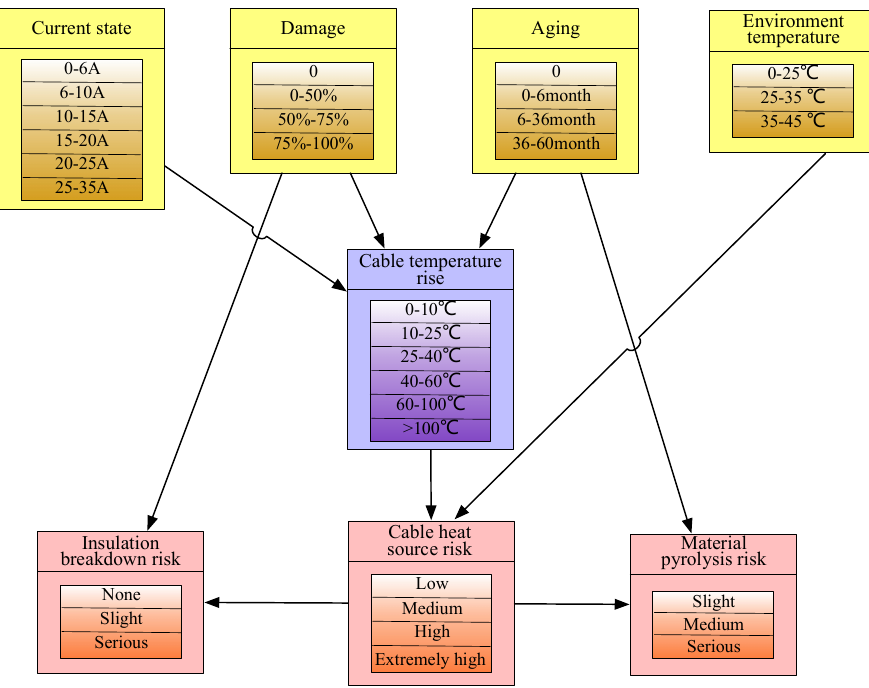
Figure 3. Structure of the BN for overload-induced early cable fire risk.